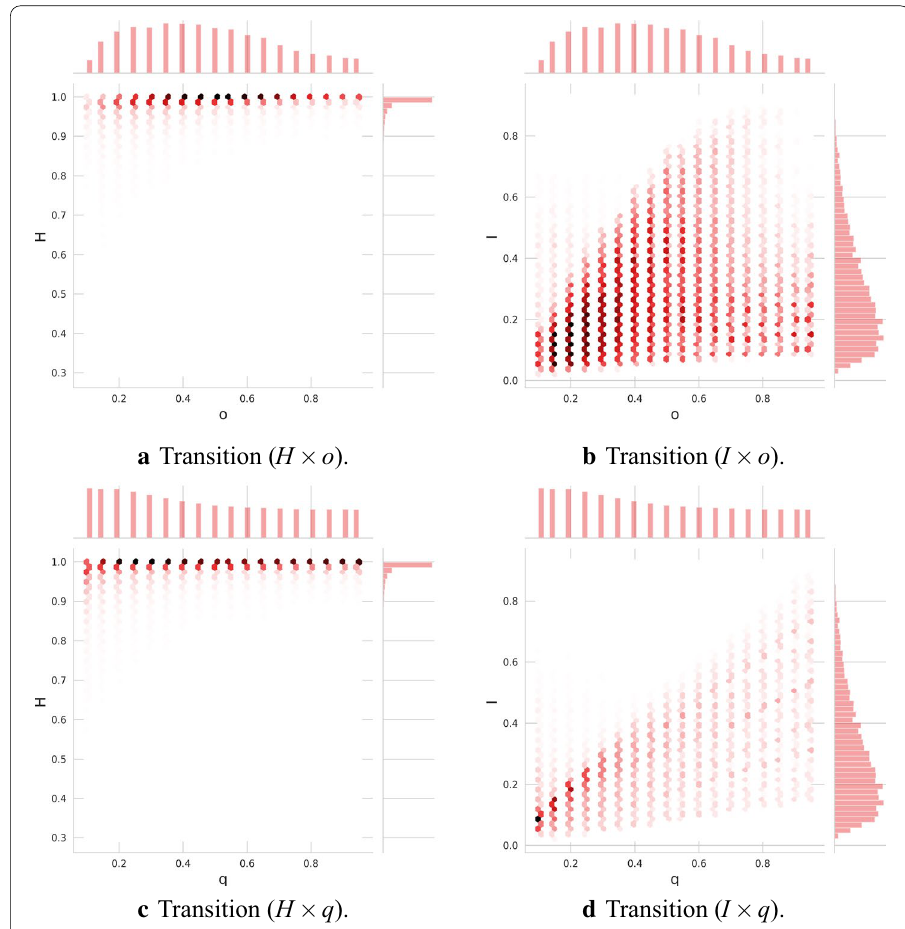
Fig. 12 Homogeneity and intensity distributions in transition coupling entanglement w.r.t. o and q